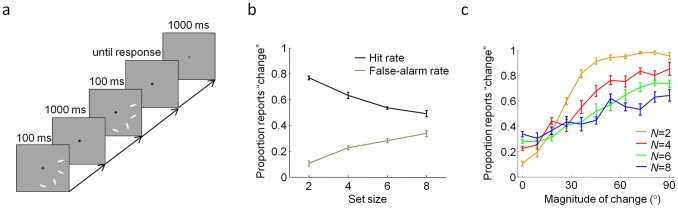
Orientation change detection.(a) Observers reported whether one of the orientations changed between the first and second displays. (b) Hit and false-alarm rates as a function of set size. (c) Psychometric curves, showing the proportion of “change” reports as a function of the magnitude of change, for each set size (mean ± s.e.m across subjects). Magnitude of change was binned into 9° bins. The first point on each curve (at 0°) contains all trials in which no change occurred, and thus represents the false-alarm rate. Using the standard formula for K would return different estimates for different change magnitudes.